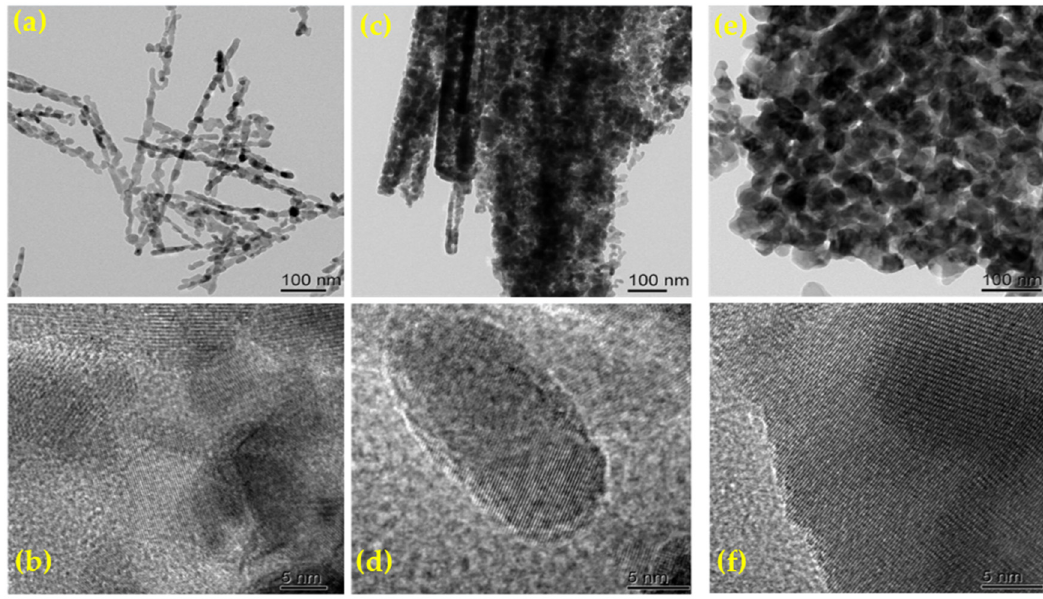
Figure 2. HRTEM images with different magnification for NiCo 2 O 4 ( a , b ), CuCo 2 O 4 ( c , d ), ZnCo 2 O 4 ( e , f ).